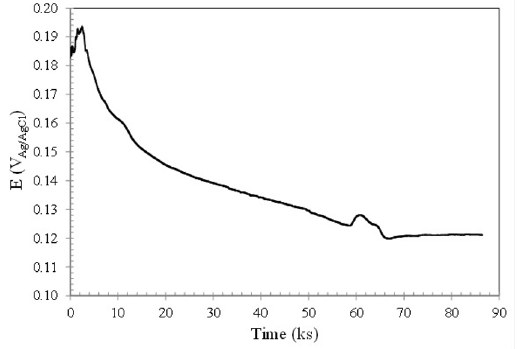
Figure 4. Open circuit potential versus time curve for the AISI 409 stainless steel in 0.1 M NaCl solution at room temperature. magnitude of the CPE (related to its capacitance) and n is the exponent of the CPE is related to the roughness of the surface 31 . The value of n denotes the deviation from the